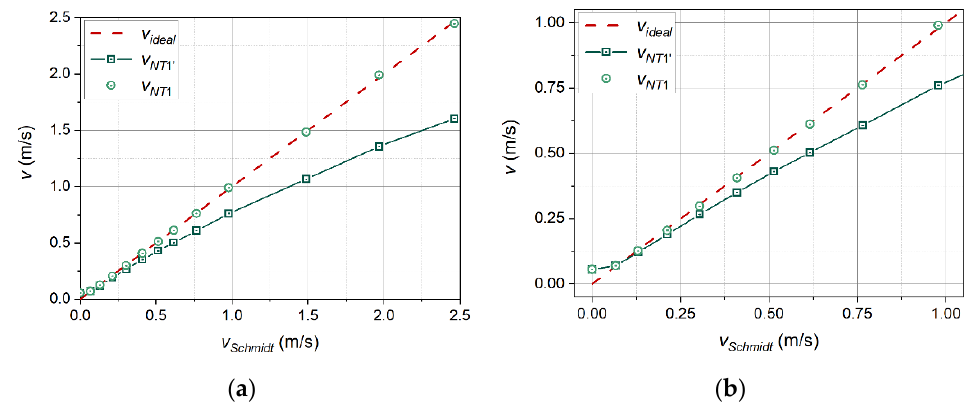
Figure 12. Velocity measurement results without correction (squares), ideal relationship (dashed line), measurement results after applying the correction (circles): all the results ( a ), and a subset of the results limited to velocities below 1 m/s ( b ).